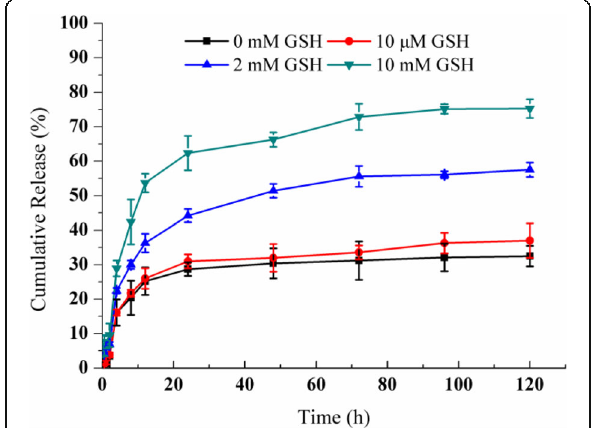
Fig. 5 In vitro release of Cur-loaded TPP-oHA-S-S-Cur micelles at different GSH concentrations ( n